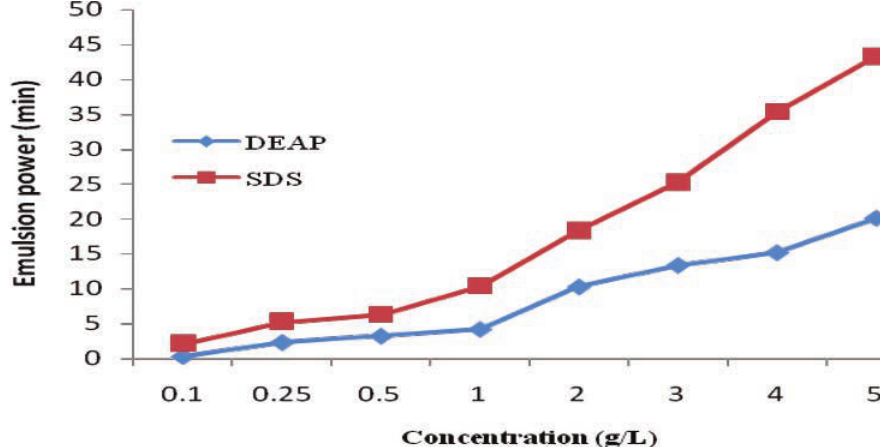
Figure 5. Emulsion stability of sodium phosphate-hydroxy ethanolamide and SDS. DEAP = Sodium phosphate-hydroxy